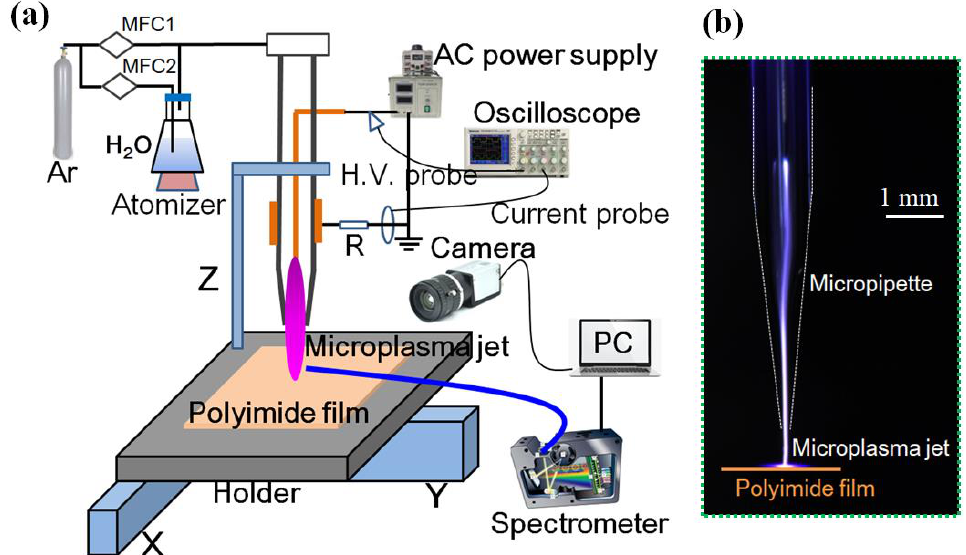
Figure 1. ( a ) Schematic diagram of the experimental setup for localized surface modification of PI film using μAPPJ; ( b ) photograph of the generated microplasma